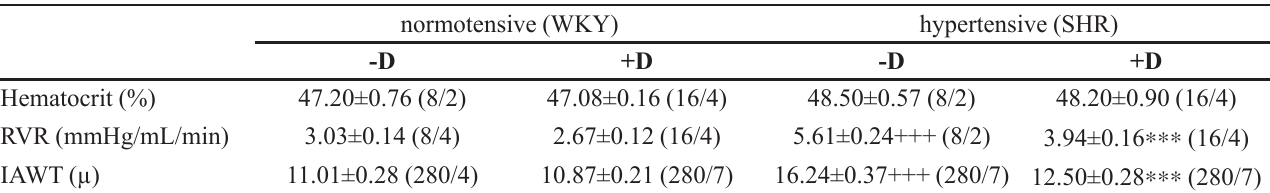
TABLE II - Effect of D- a -Tocopherol (D) on hematocrit , renal vascular resistance (RVR), and interlobular artery wall thickness (IAWT) in SHR and control rats